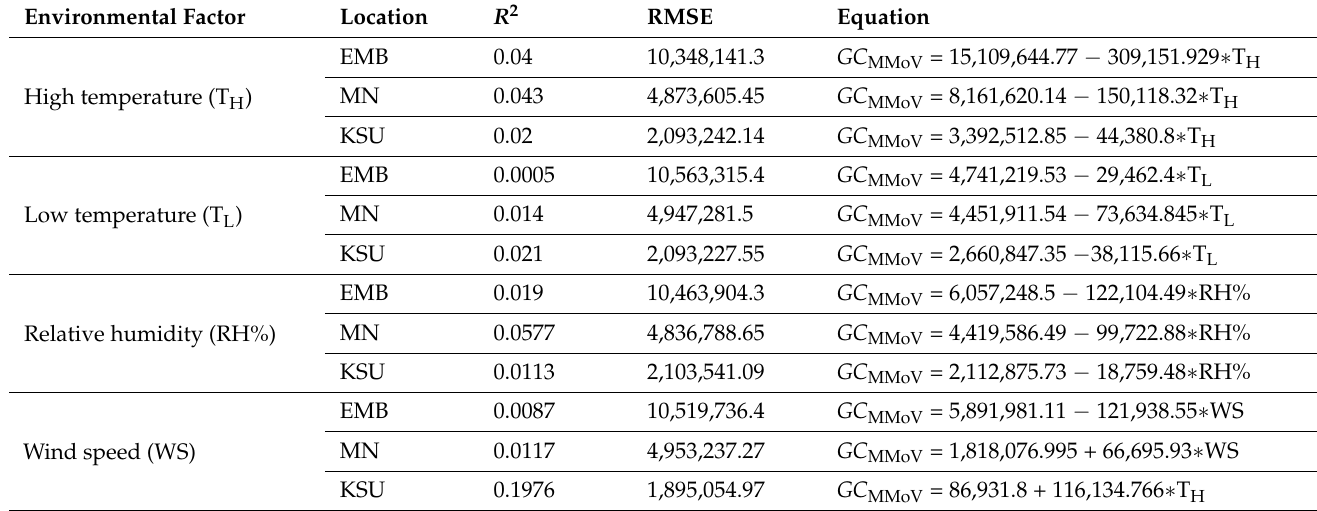
Table 2. Significance of environmental factors’ influences on the concentration of PMMoV.